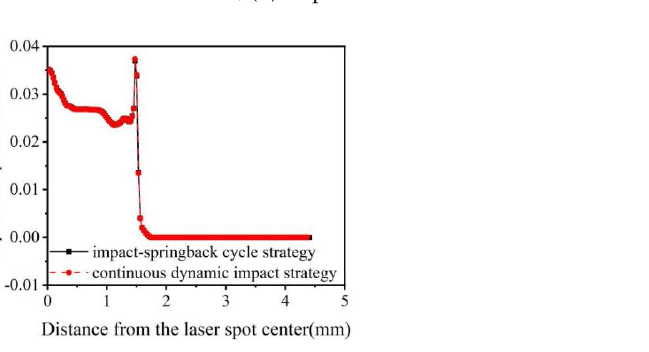
Figure 10. Residual stresses in 20CrMnTi under two impact strategies with double impacts. ( a ) Surface residual stress distribution; ( b ) Depth direction residual stress distribution.